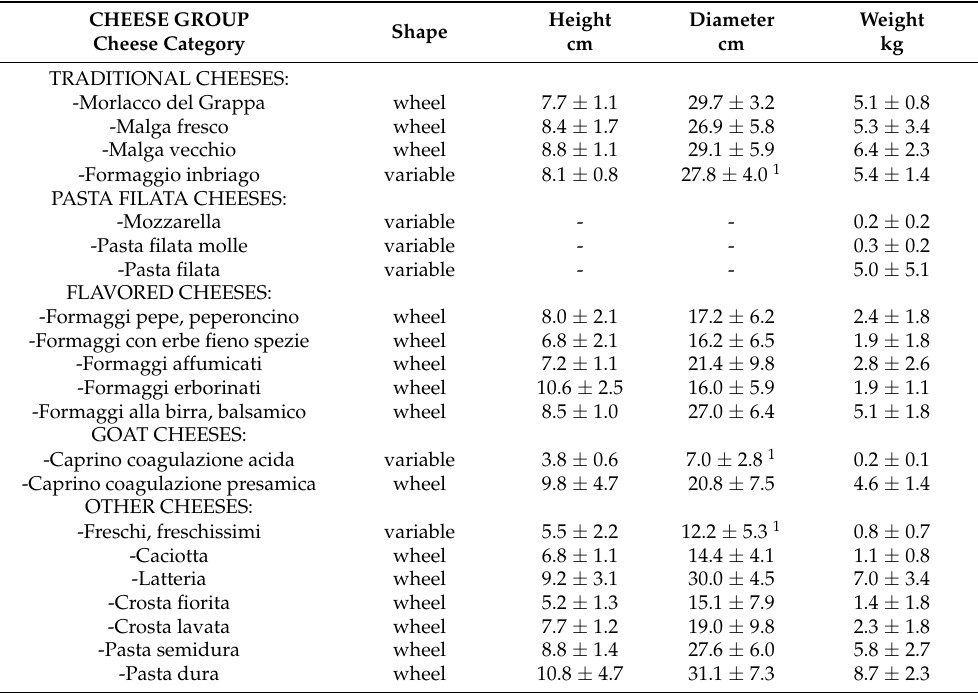
Table 4. Shapes and sizes of the non-PDO cheeses (averages and standard deviations by cheese category).